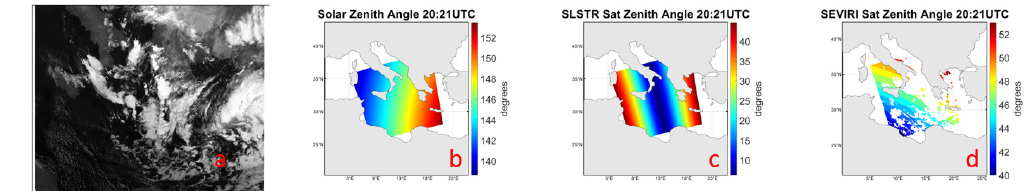
Figure 12. ( a ): SLSTR nighttime false color infrared image of the Mediterranean Sea region on 23 December 2019, 20:21:51 UTC. ( b ): Solar zenith angles at the same time. ( c ): Corresponding SLSTR satellite zenith angles. ( d ): Corresponding SEVIRI satellite zenith angles, only the points with available SEVIRI matched up pairs are shown.